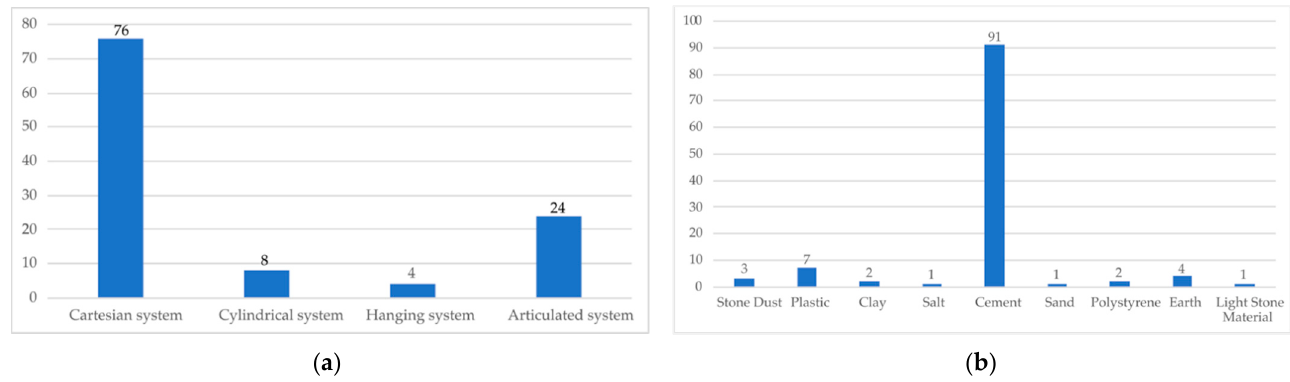
Figure 6. ( a ) Number of cases by deposition systems; ( b ) number of cases by base material used.